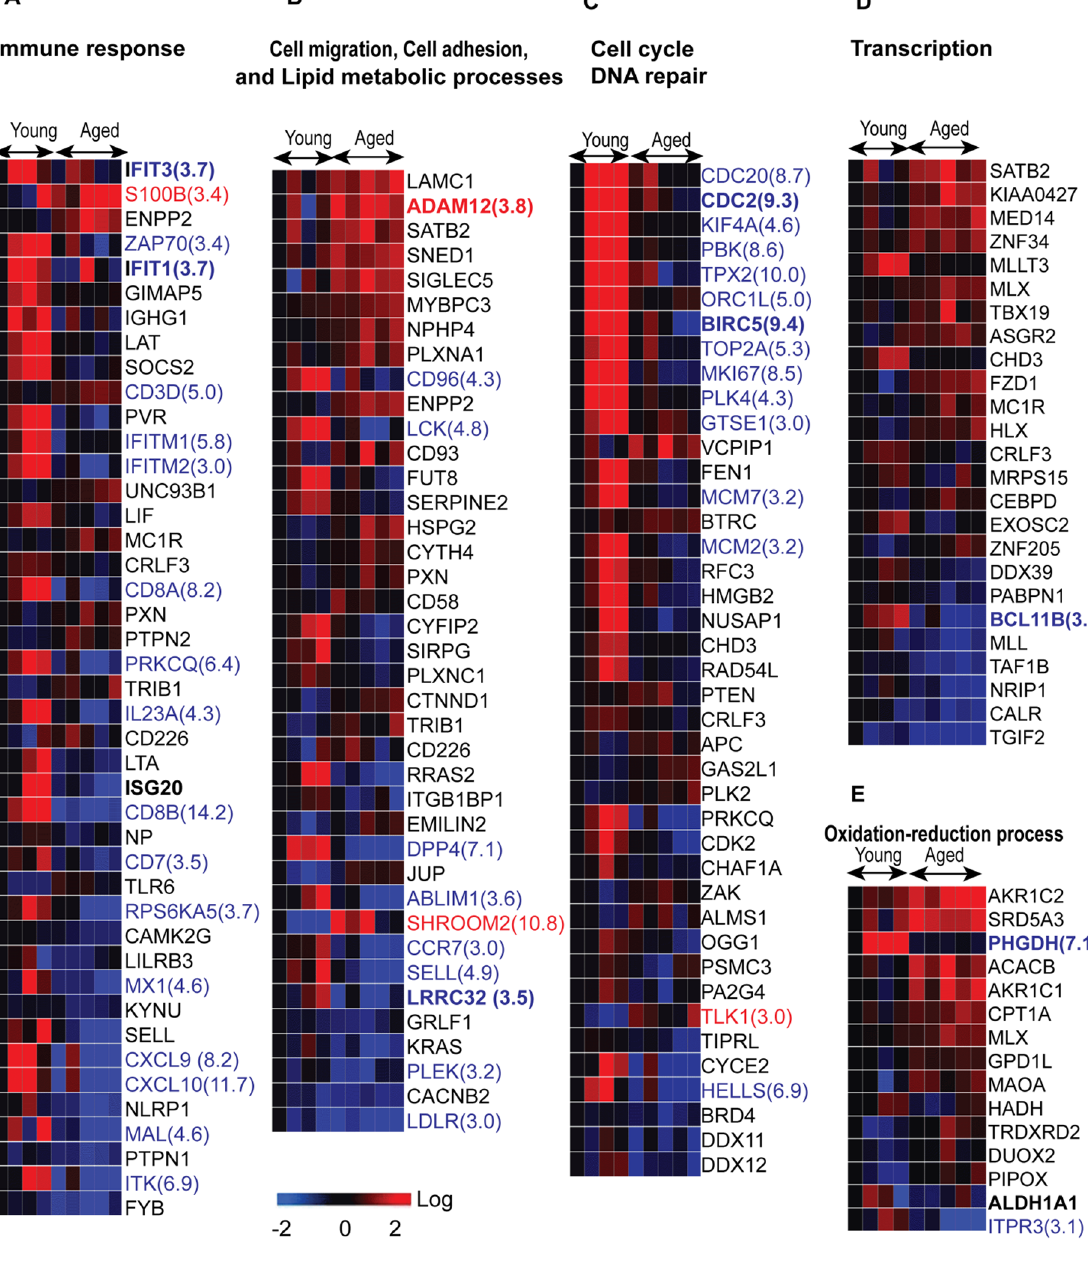
Figure 3. Heat maps of expression changes of genes in cell processes affected by donor age. (A–F) Heat maps of the genes by functional group (for detailed gene information, see Table S2, worksheets A, B). Expression of genes in red text were increased, and of genes in blue decreased, by $ 3 fold. Each column represents a donor; each row refers to a gene.